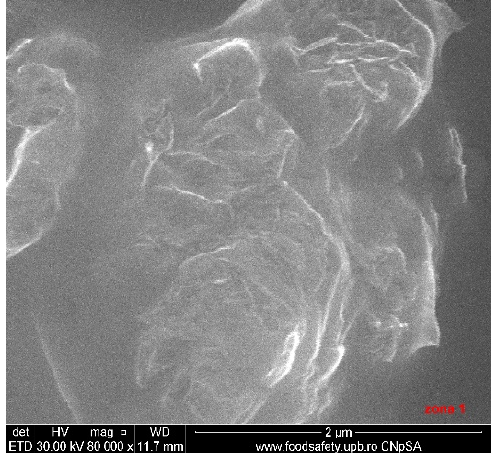
Figure 12. SEM image of 4%rGO-SiO 2 -P 2 O 5 /ITO.